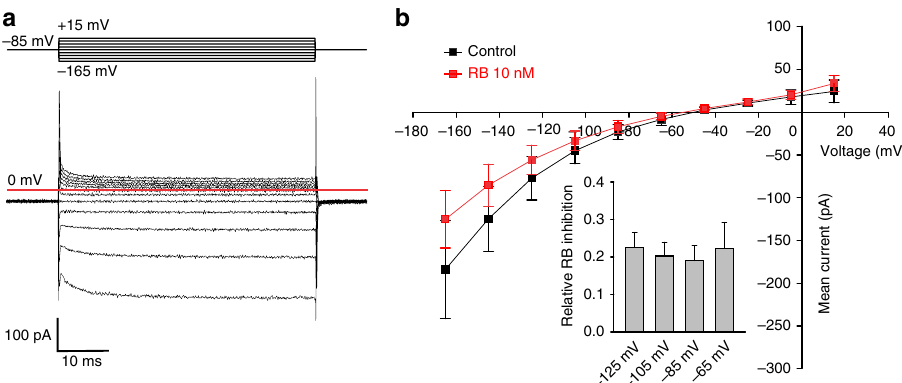
Fig. 3 RB has only minor effects on VGLUT1 Cl − currents. a Representative current responses from HEK cells expressing internalization-defective VGLUT1 to voltage steps from − 165 mV to +15 mV in 20 mV increments from a holding potential of − 85 mV. b Mean current voltage relationships from VGLUT1 in the absence (black square n = 5) and in the presence (red square n = 5) of 10 nM RB. Inset, relative RB inhibition at different voltages. Error bars represent